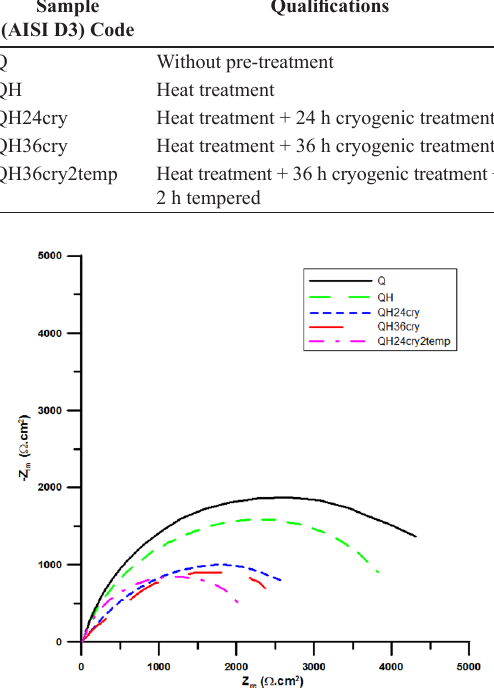
Figure 2. EIS data represented by Nyquist diagrams for different pre-treated AISI D3 steel samples in 3.5% NaCl solution.